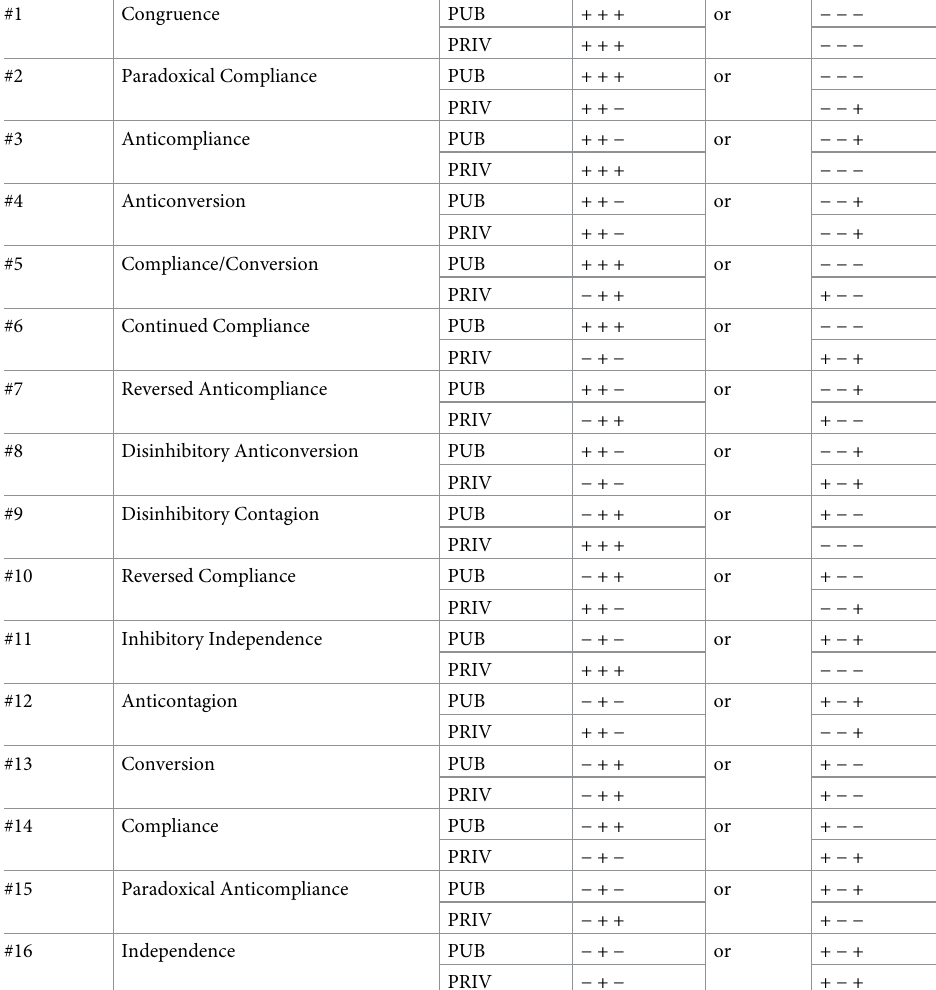
Table 1. The 16 possible response patterns introduced within the four-dimensional model of social response